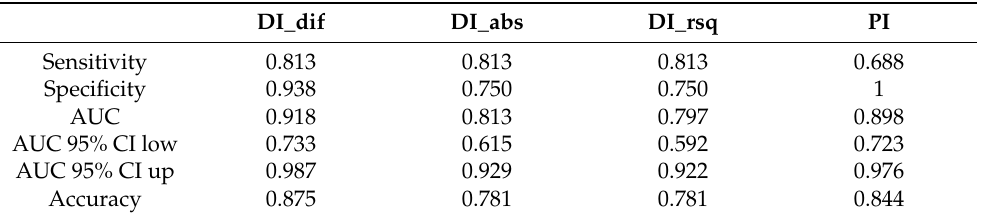
Table 2. Receiver operating characteristic (ROC) curve showing the performance of given indices to discriminate between baseline ICP vs. plateau wave. AUC—area under the curve, CI—confidence interval.